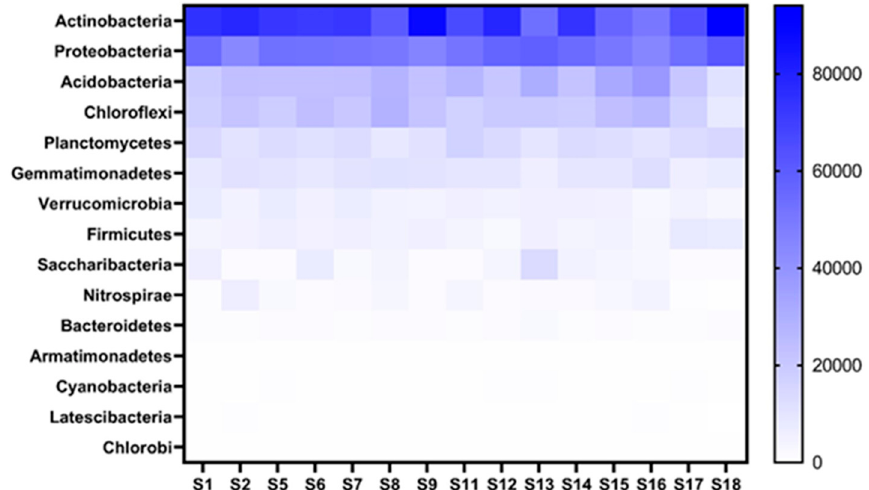
Figure 6. Heatmap indicating the top bacterial phyla and their abundance associated with the soybean rhizosphere of the 15 fields (S1–S18) sampled from the Highveld region, Mpumalanga province, South Africa. The darkness of the blue color indicates the abundance, with darker colors being more abundant.